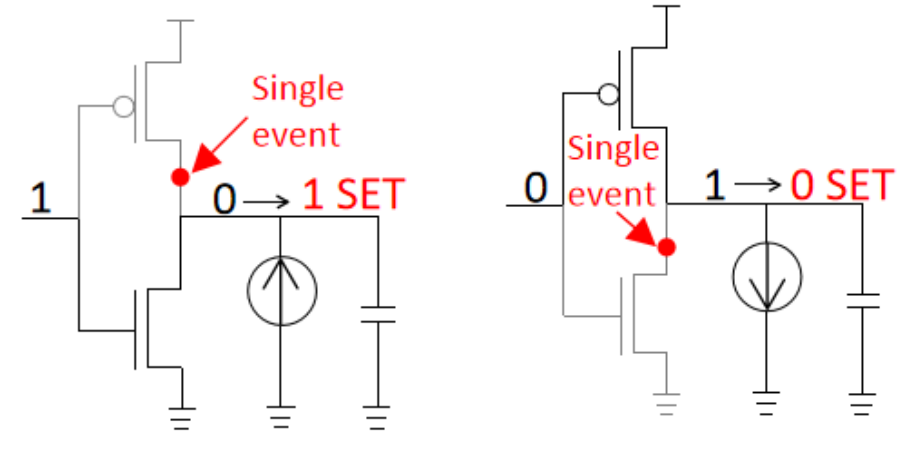
Figure 8. Circuit simulation fault injection.